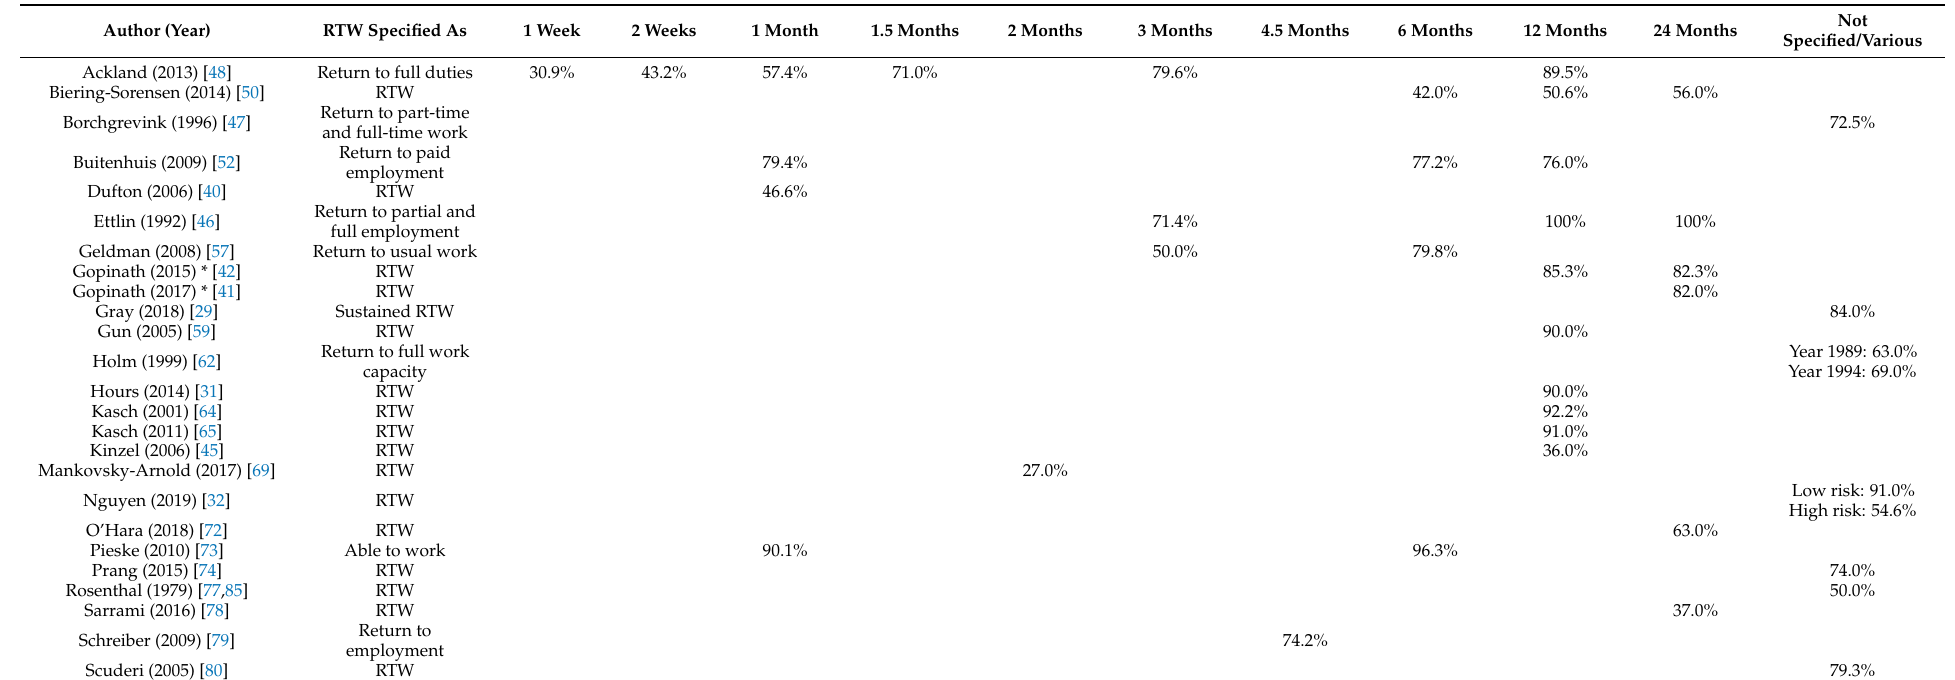
Table 3. Return to work percentages by time